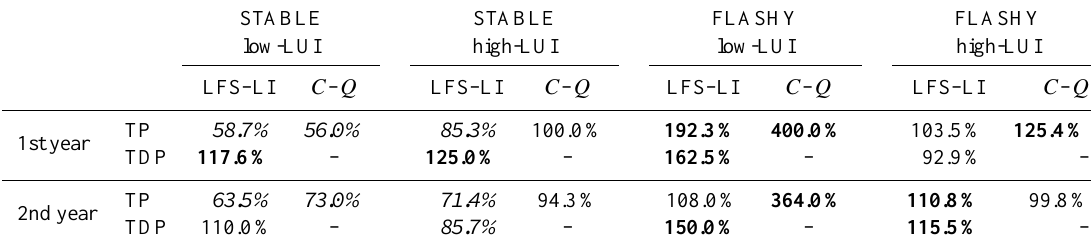
Table 6. The percentages summarizes the relative fit of alternative estimation methods in relation to the reference annually exported load estimated by the composite sampling programme (see Table 5 for references). 100% represents the same annual P exported in kgha − 1 yr − 1 . Values below 100% (italics) represent underestimation (less than 90%) relative to the estimation of composite sampling. Values over 110% (bold) represent overestimation relative to the estimation of composite sampling. STABLE: low-flashiness Danish streams; FLASHY: Uruguayan flashy streams; low- and high-LUI: low and high land use